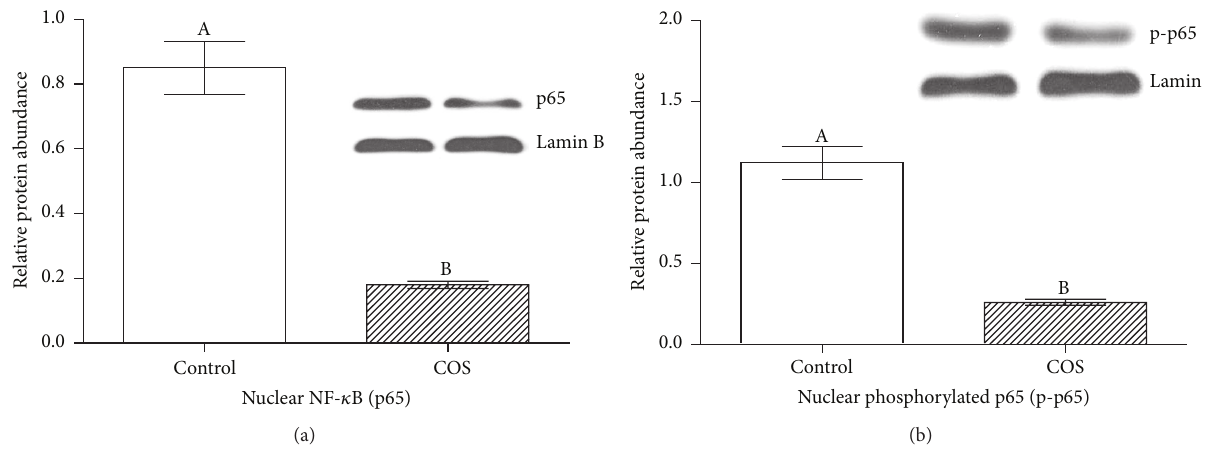
Figure 5: Immunoblotting of (a) nuclear NF- 𝜅 B (p65) and (b) phosphorylated nuclear NF- 𝜅 B (p65) in control and COS group ( 𝑛 = 6